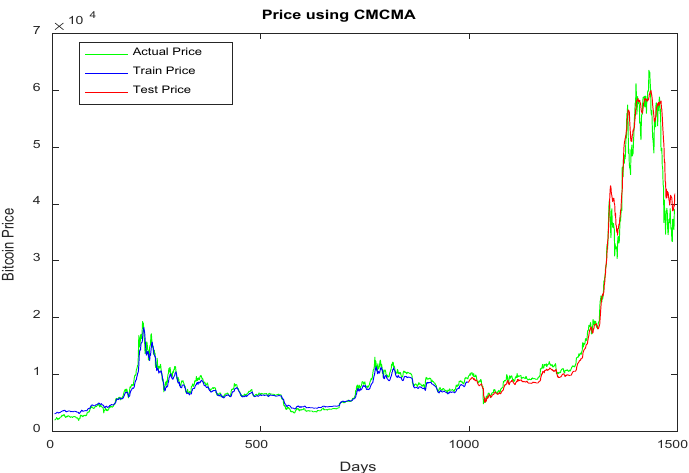
Figure 4. Bitcoin prices using CMCMA for BTC/USD dataset.